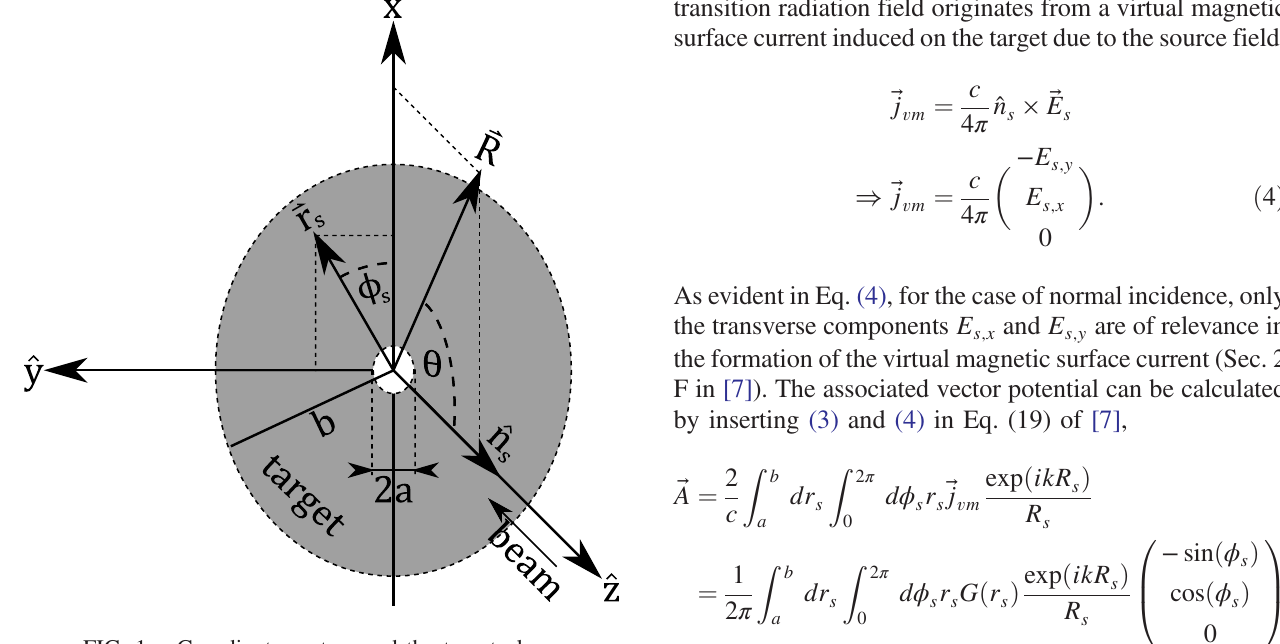
FIG. 1. Coordinate system and the target